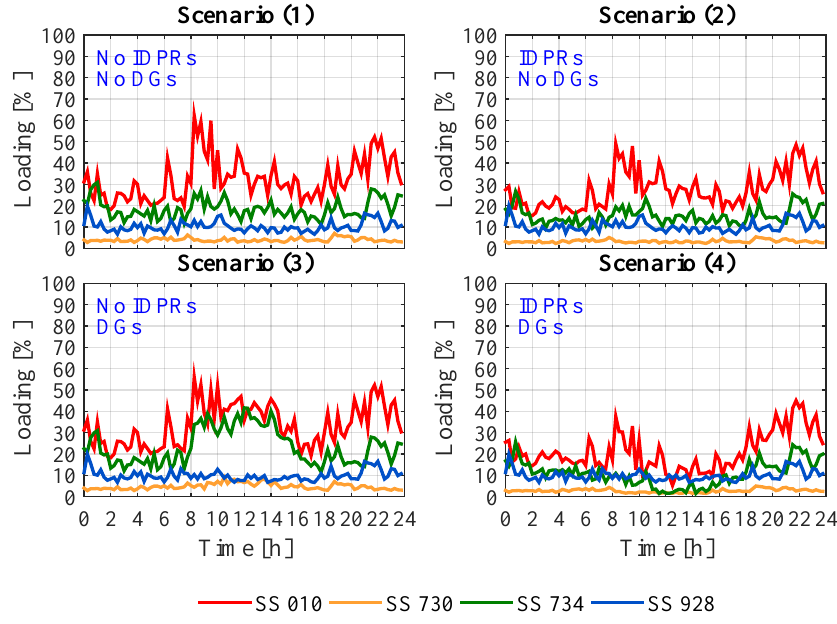
Figure 14. Transformer loading for each